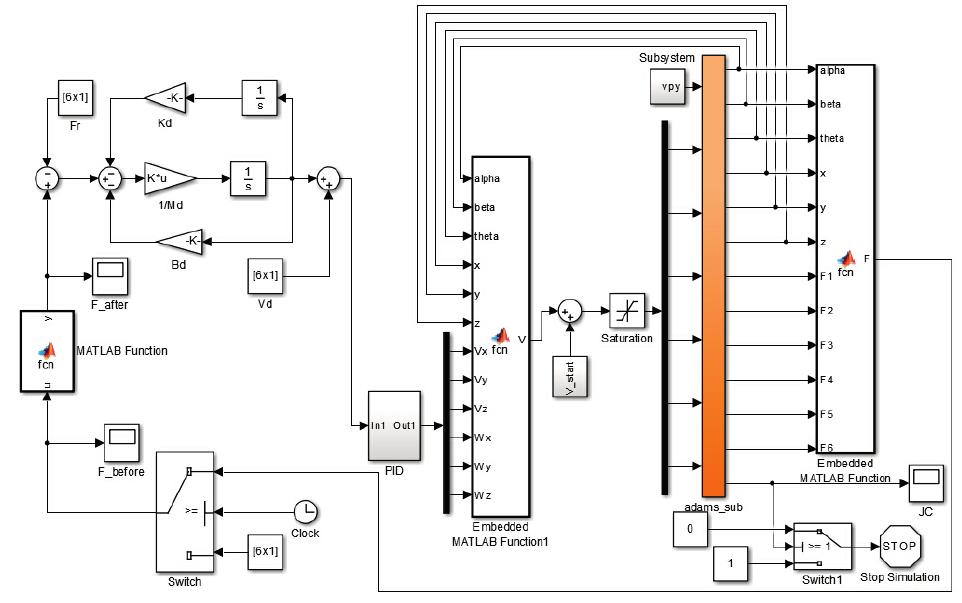
Figure 10. The control system built in MATLAB.